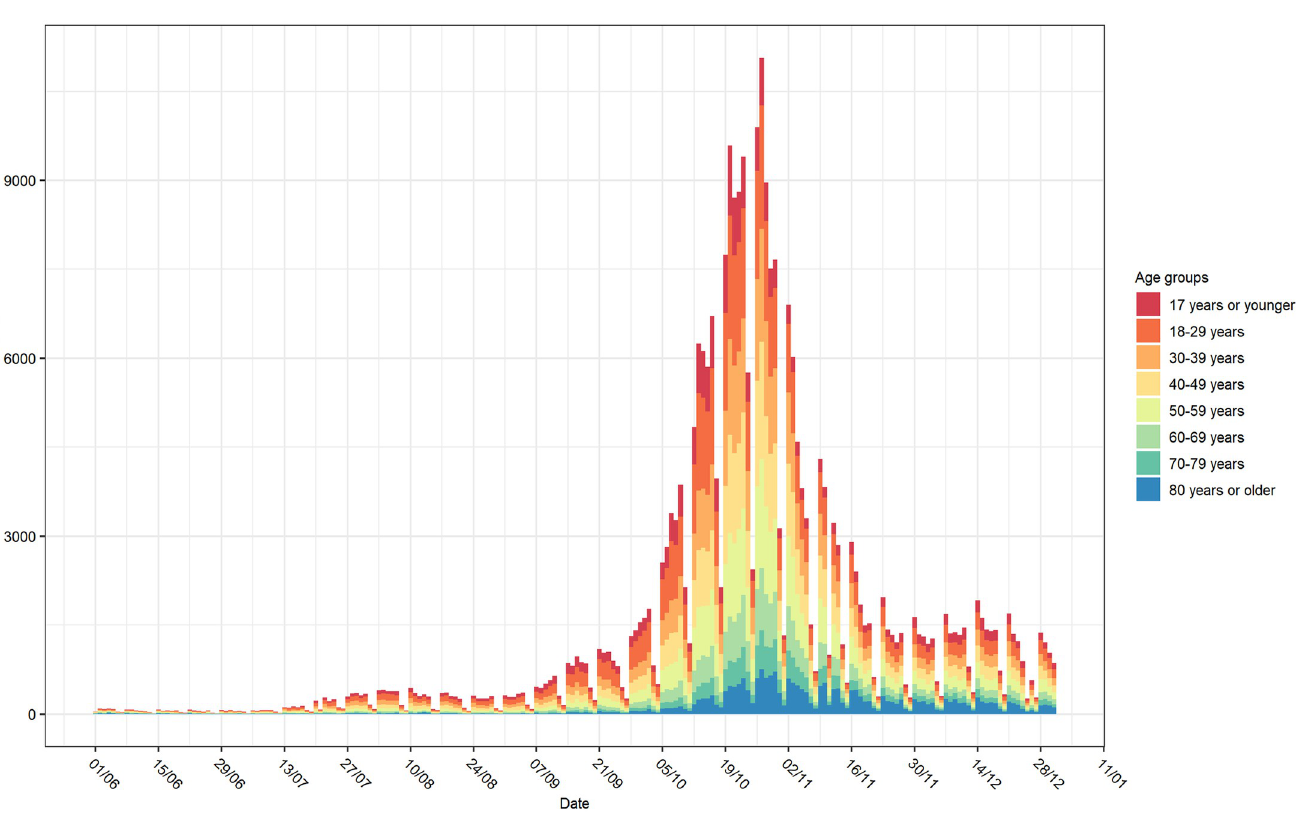
Fig 2. Distribution of COVID-19 cases per age group from 1 June until 31 December 2020.